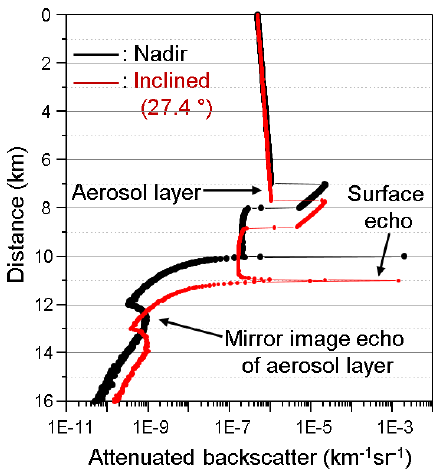
Figure 3. Profiles of the attenuated backscatter (ATB) coefficient (black – nadir-looking, red – inclined at 24.7 ◦ ) as a function of the distance from the lidar position. The lidar altitude is